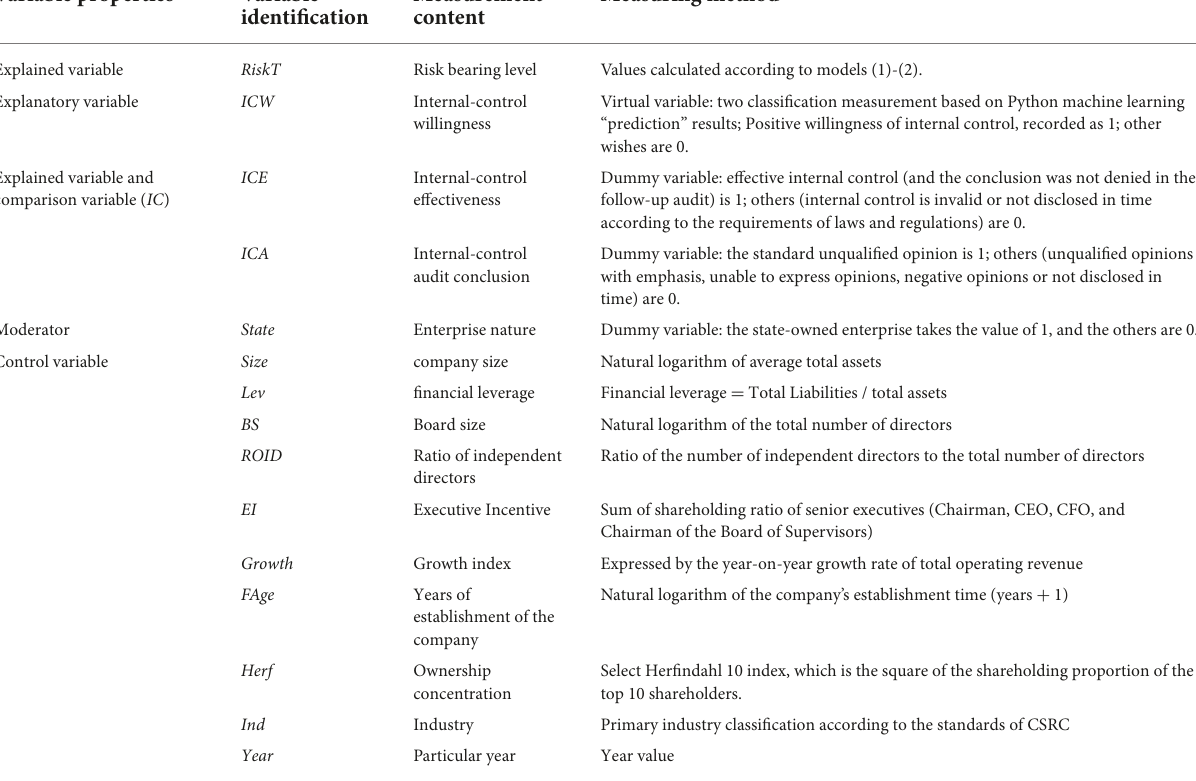
TABLE 1 Table of research variables. Variable properties